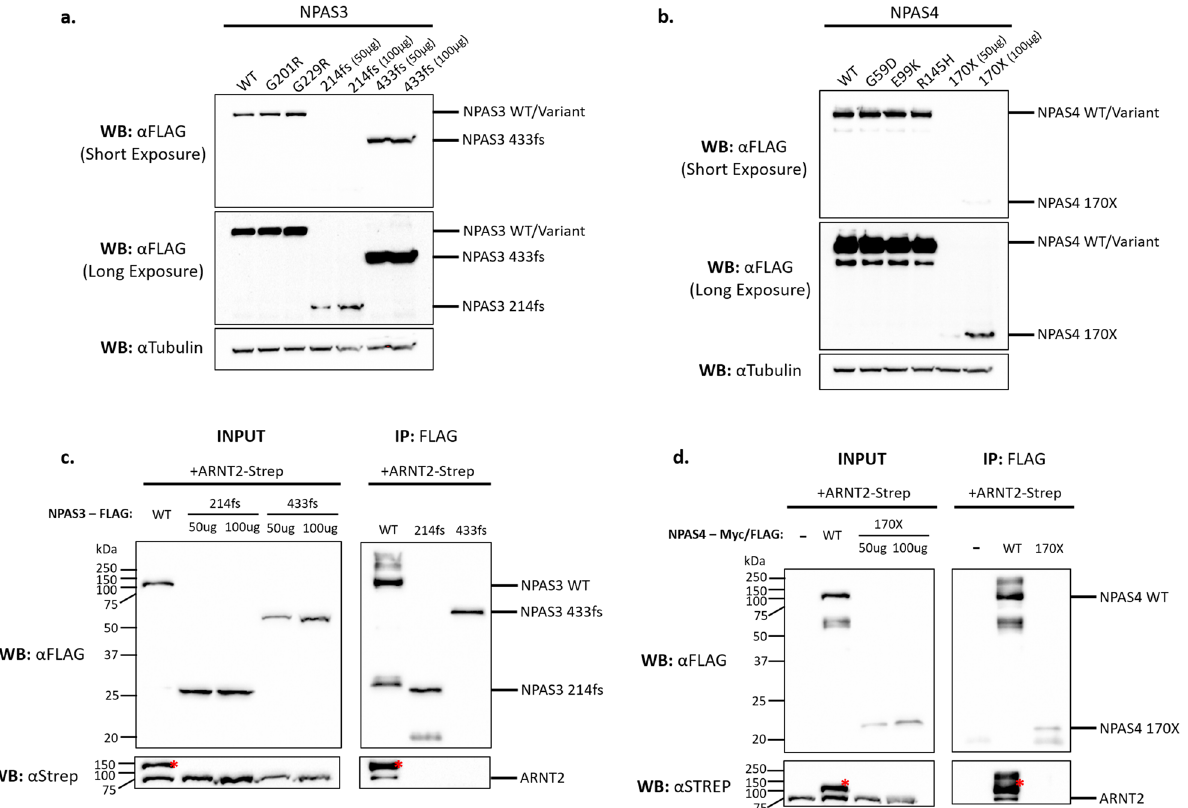
Figure 3. Mechanism for variant loss of function. ( a , b ) HEK293T cells were transiently transfected with the NPAS3 or NPAS4 variants, and expression was detected by western blot. The NPAS3 214fs and NPAS4 170X variants were expressed at a lower level than the wildtype protein. For clarity of protein expression, both short and long exposures of the same western bot have been presented. All replicates are included in Supplementary Fig. S2, S3. ( c , d ) HEK293T cells were transiently transfected with a variant of either NPAS3-FLAG or NPAS4- Myc/FLAG and ARNT2-Strep. 500 μg of whole cell lysate was then subjected to FLAG